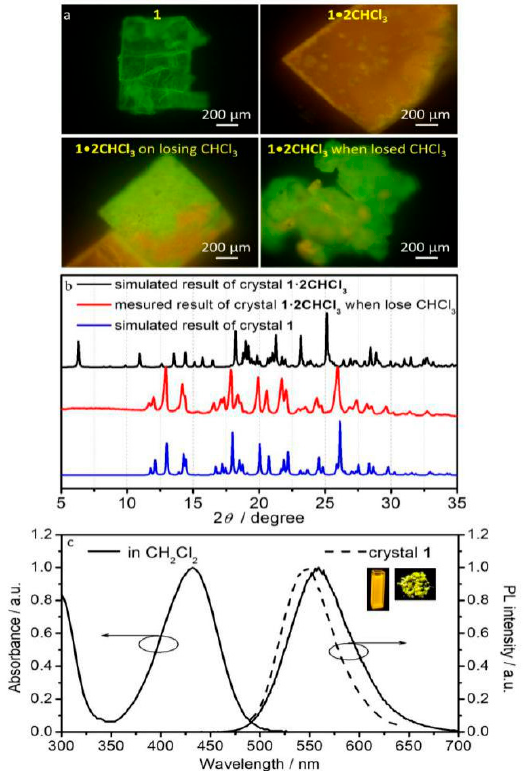
Figure 2 . ( a ) Fluorescence microscope photographs of crystal 1, crystal 1•2CHCl 3 , 1•2CHCl 3 with